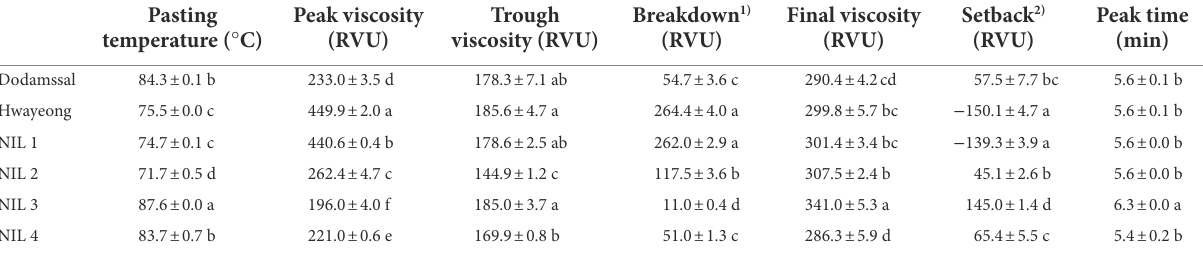
TABLE 1 Pasting properties of rice flours analyzed by rapid visco-analyzer. Pasting temperature ( °